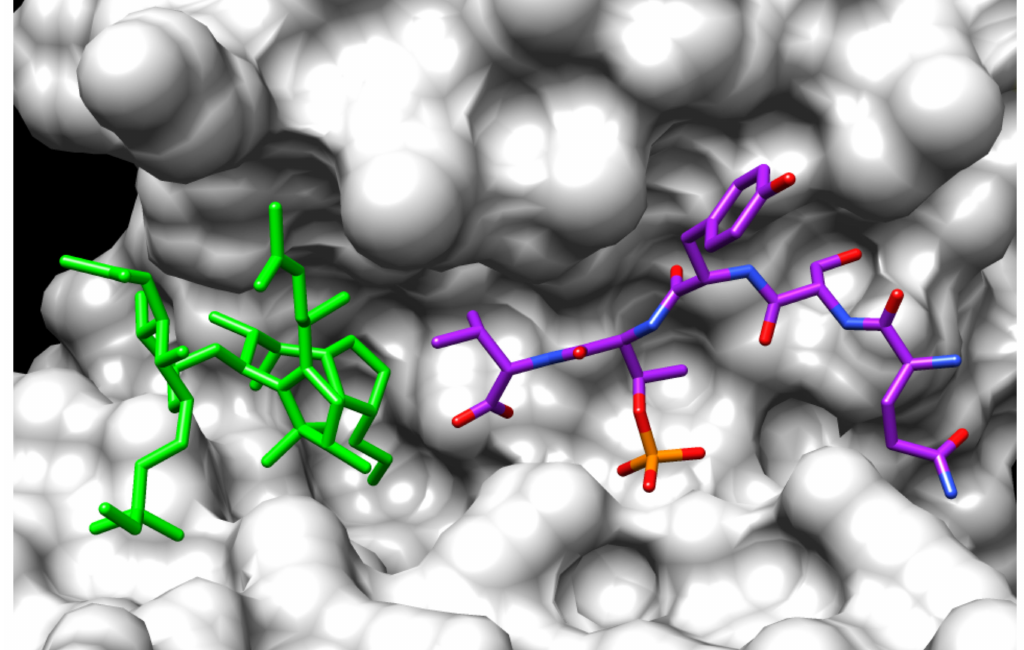
Figure 10. Crystal structure of the FC/phosphopeptide/14-3-3 ternary complex. Ternary complex between FC (green sticks), the H + -ATPase pentapeptide Gln-Ser-Tyr-phosphoThr-Val (purple stick) and 14-3-3 (grey surface). The interaction between the H + -ATPase peptide and FC involves the C-terminal valine of the peptide and the terpenoid moiety of FC. Molecular graphics were performed with UCSF Chimera, developed by the Resource for Biocomputing, Visualization, and Informatics at the University of California, San Francisco [106], using 1O9F pdb